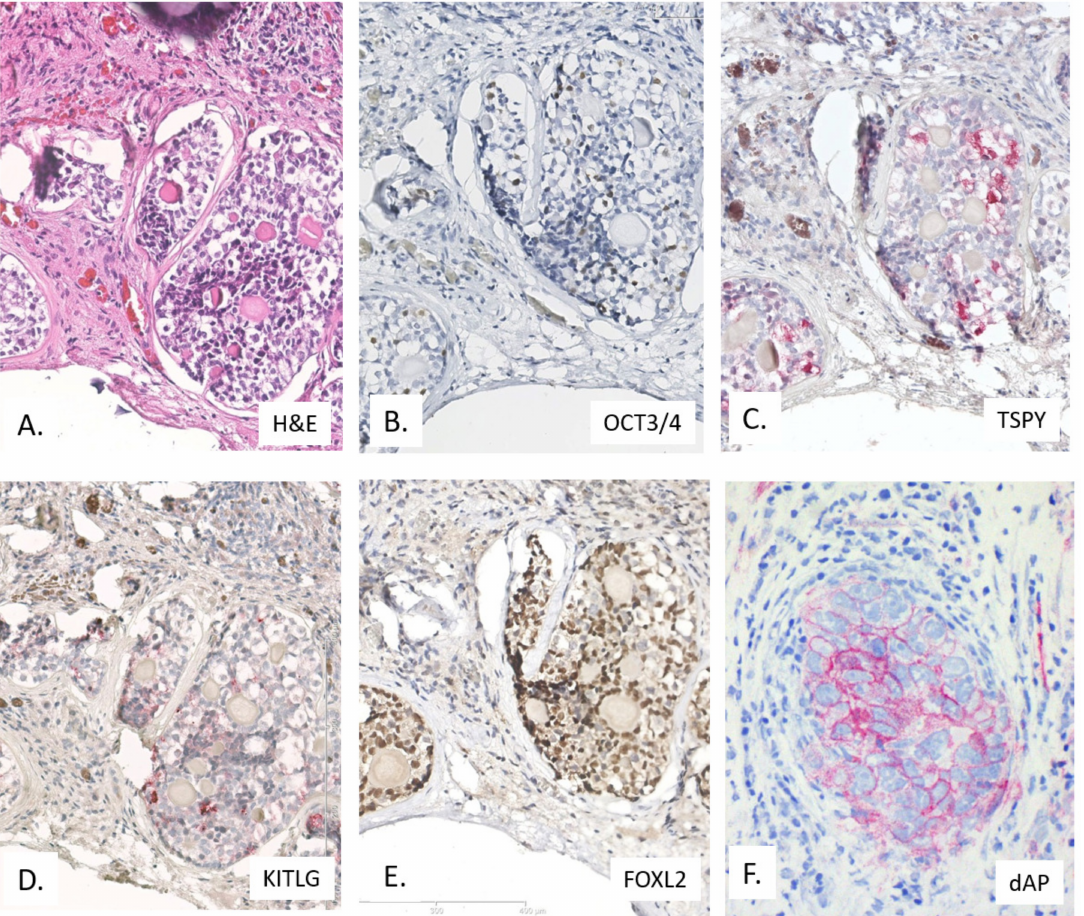
Figure 3. Representative examples of gonadoblastoma (GB) stained using Hematoxylin & Eosin (H&E) ( A ) and immunohistochemistry for OCT3 / 4 ( B ), TSPY ( C ), KITLG ( D ), FOXL2 (granulosa cell marker) ( E ), as well as direct alkaline phosphatase (dAP) ( F ). Multiplication 200 ×